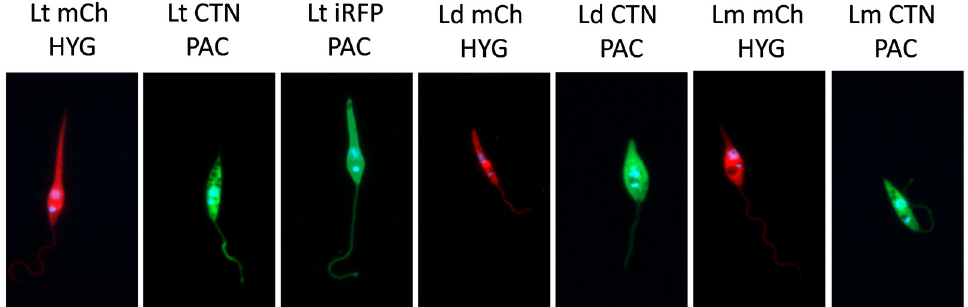
Fig 1. Engineered Leishmania parental strains. Representative confocal microscopy pictures of promastigotes of the parental fluorescent strains of Leishmania used for the intraclonal and interspecies outcrossings. Lt mCh HYG: L . tropica mCh HYG (561 nm); Lt CTN PAC: L . tropica CTN PAC (488 nm); Lt iRFP PAC: L . tropica iRFP PAC (640 nm); Ld mCh HYG: L . donovani mCh HYG (561 nm); Ld CTN PAC: L . donovani CTN PAC (488 nm); Lm mCh HYG: L . major mCh HYG (561 nm); Lm CTN PAC: L . major CTN PAC (488 nm). The wavelength refers to the excitation laser.